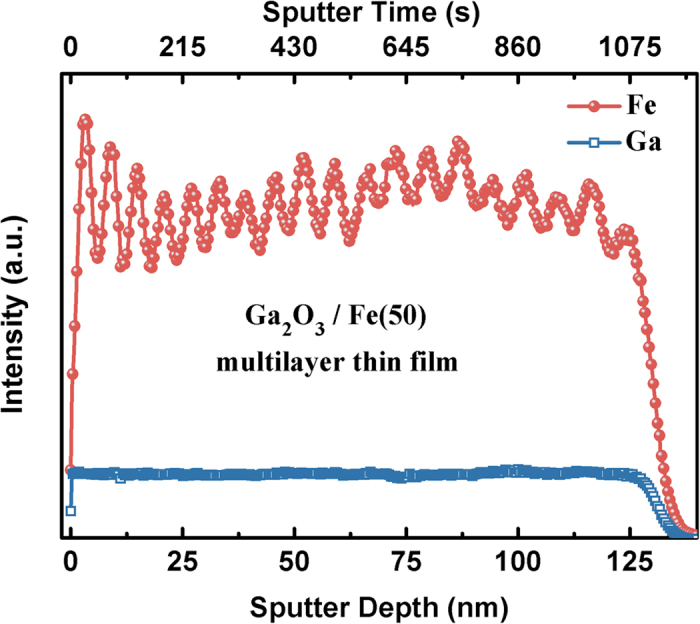
Fe and Ga SIMS depth profiles for the Ga2O3/Fe(50) multilayer thin film.